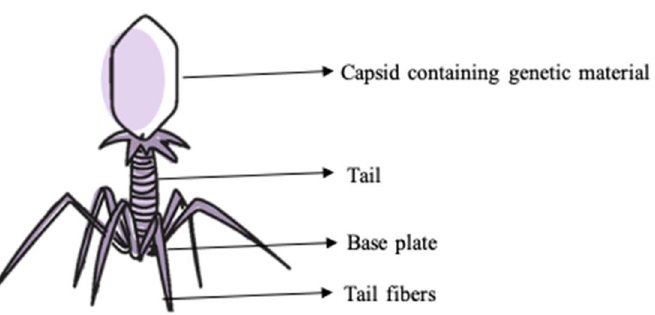
Figure 6. Basic phage structure with an icosahedral head, contractile tail terminating in 6 tail fibers, representative of the FO1a phage.